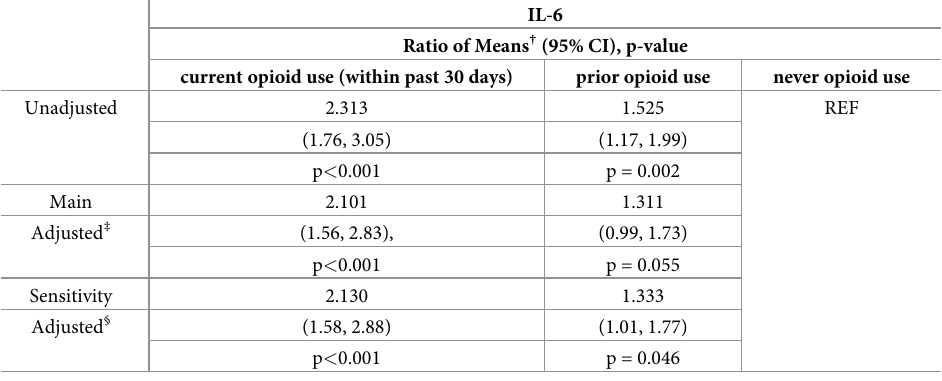
Table 3. Association between opioid use category and plasma concentrations of IL-6 among a cohort of Russian PLWH (N = 344). IL-6 Ratio of Means † (95% CI), p-value current opioid use (within past 30 days) prior opioid use never opioid use Unadjusted 2.313 1.525 REF (1.76, 3.05) (1.17, 1.99) p < 0.001 p = 0.002 Main 2.101 1.311 (1.56, 2.83), (0.99, 1.73)Adjusted ‡ p < 0.001 p = 0.055 Sensitivity 2.130 1.333 (1.58, 2.88) (1.01, 1.77)Adjusted § p = 0.046